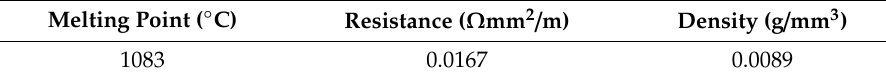
Table 2. Properties of electrode’s material [24].